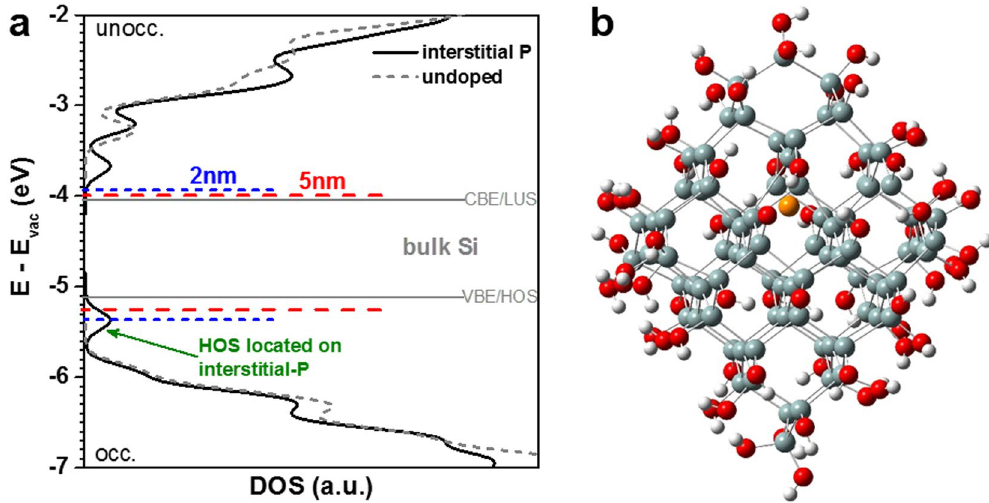
Figure 5. Results of density functional theory simulations. ( a ) Density of states (DOS) of a pristine Si 84 (OH) 64 approximant (grey dotted curves, d NC = 1.5 nm) together with the DOS of a Si 84 (OH) 64 approximant containing interstitial P (black solid curves). The latter is shown in ( b ) with an interstitial P-atom in the NC centre (Si- atoms: grey, O-atoms: red, H-atoms: white, P-atom: orange). For bulk Si (grey solid lines) the HOS-level of interstitial P is well below the VB-edge and hence no recombination centre. QC-induced widening of the fundamental gap results in the HOS energy of Si NCs approaching the P-induced defect level. As a consequence, small NCs (blue dotted line) are more strongly subject to PL quenching than larger NCs (red dashed line).